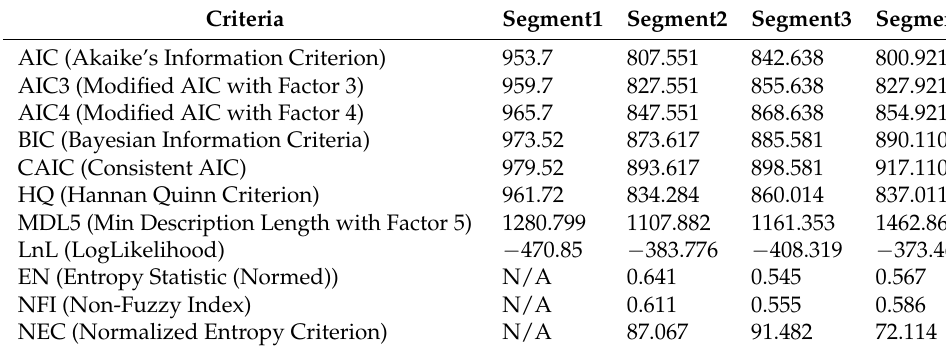
Table 4. Fit indices to assess heterogeneity.